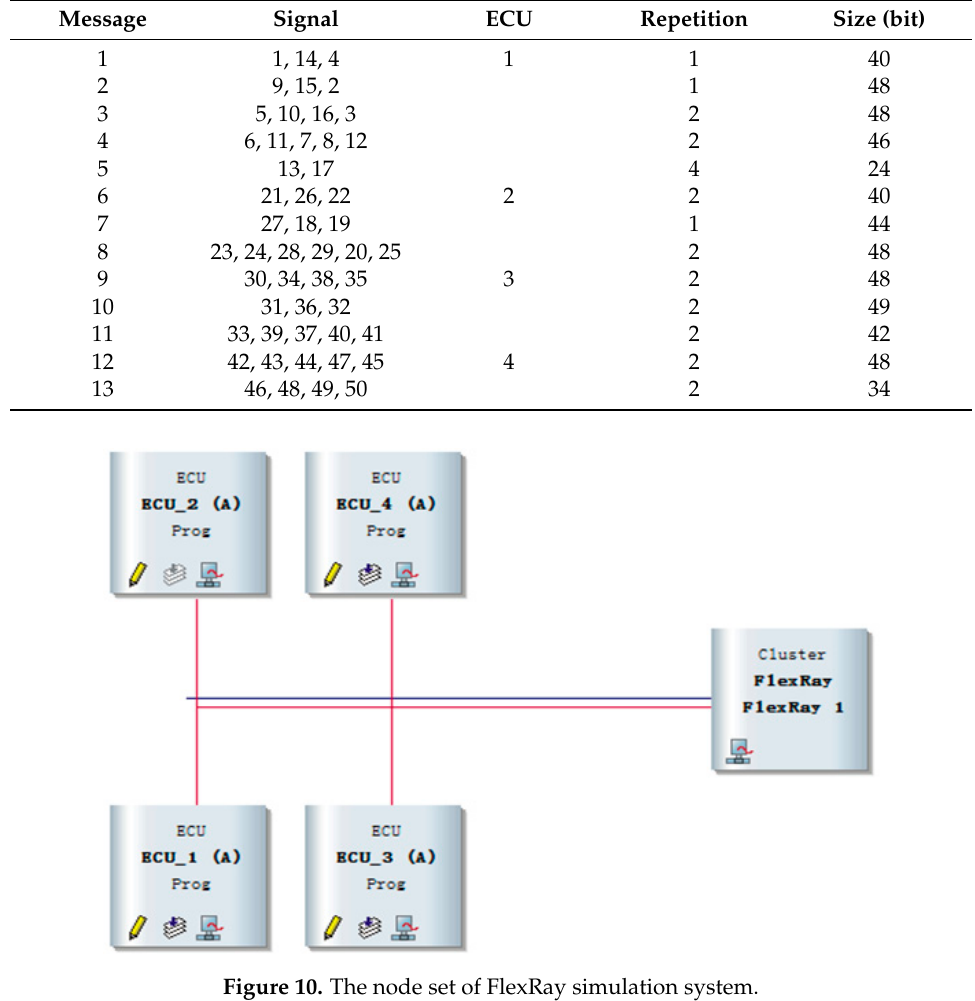
Table 7. Signal packing for BCBFD (Bandwidth Consumption and Best Fit Decreasing) scheduling.